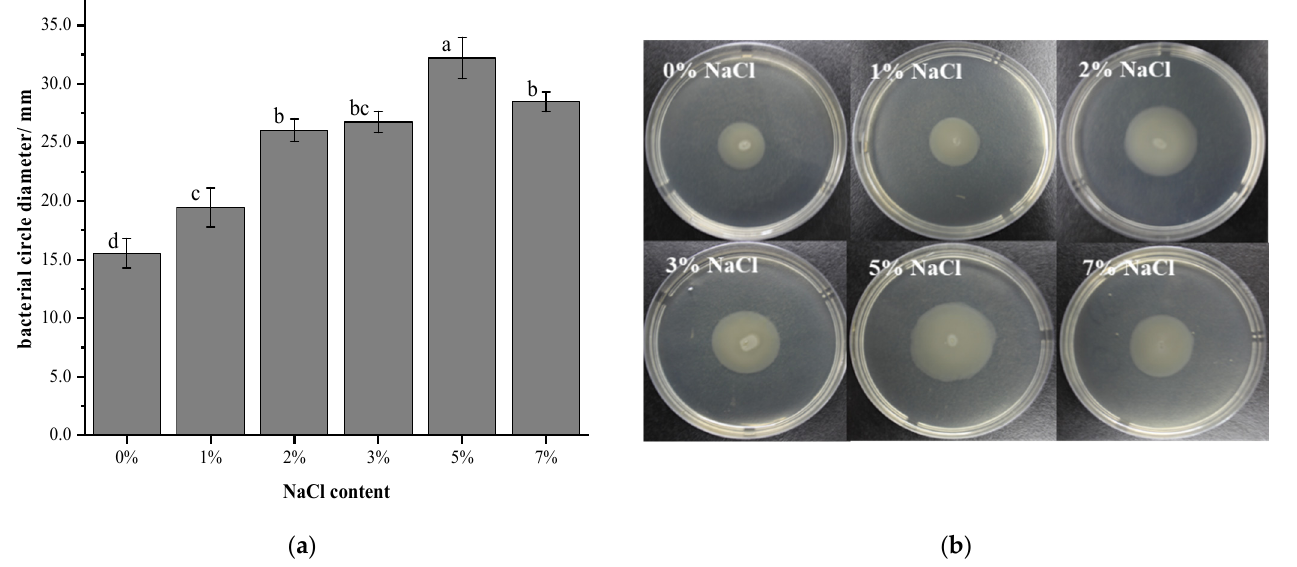
Figure 3. Swimming motility of V. brasiliensis under different NaCl concentrations. ( a ) 0.3% agar plates bacteria circle diameter (mm) were measured after cultivated in various NaCl medium, and the value is represented by three repetitions mean ± sd. Different lowercase letters denote significant differences ( p < 0.05); ( b ) 0.3% agar medium obtained the swimming circle of V. brasiliensis cultured in various NaCl concentrations.